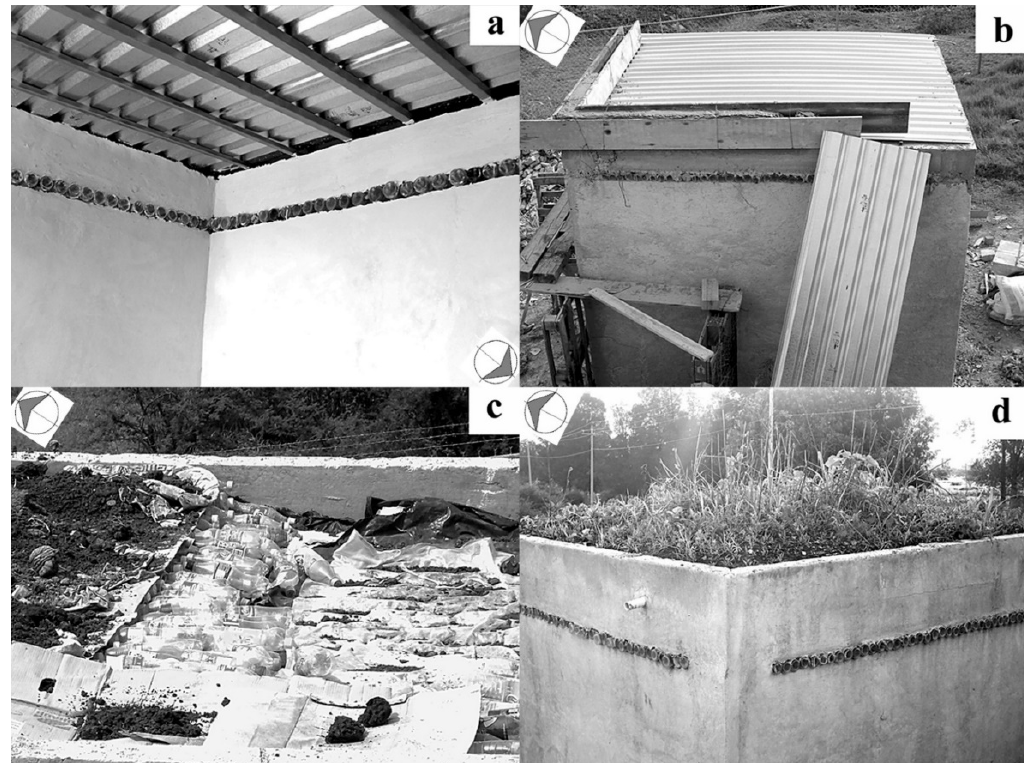
Figure 6. ( a ) Six steel tubular supports with three corrugated galvanized sheets placed on a 3 × 3 m area; ( b ) their borders were embedded with a surrounding concrete wall; ( c ) the multilayer of waste materials with uncapped PET bottles, soil, and a green roof; ( d ) an upper perspective including the